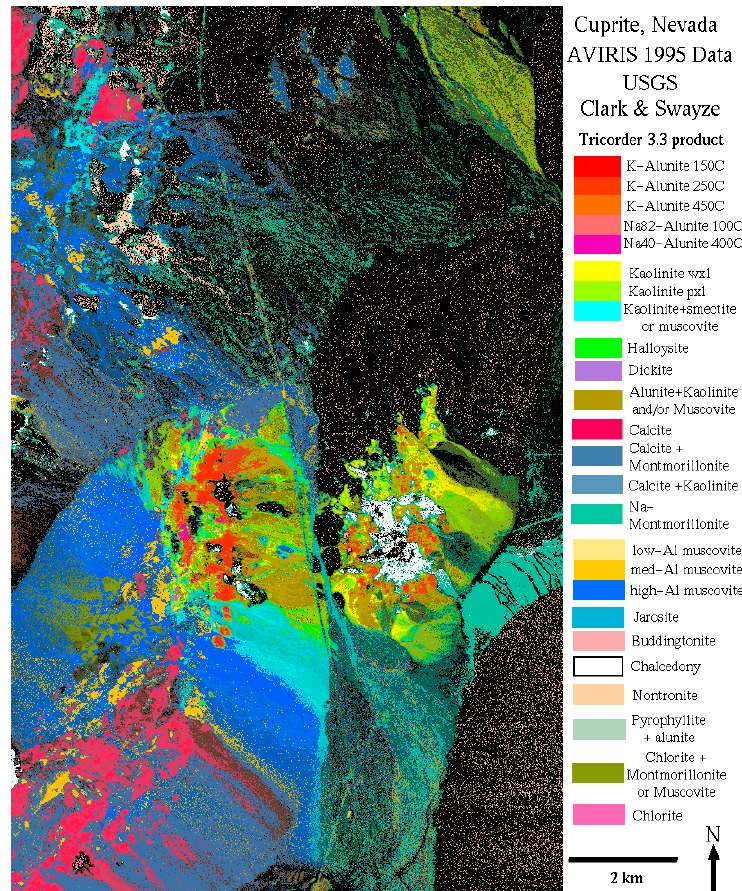
Figure 8. USGS map showing the location of different minerals in the Cuprite mining district in Nevada. The map is available online at http://speclab.cr.usgs.gov/cuprite95.tgif.2.2um_map.gif.